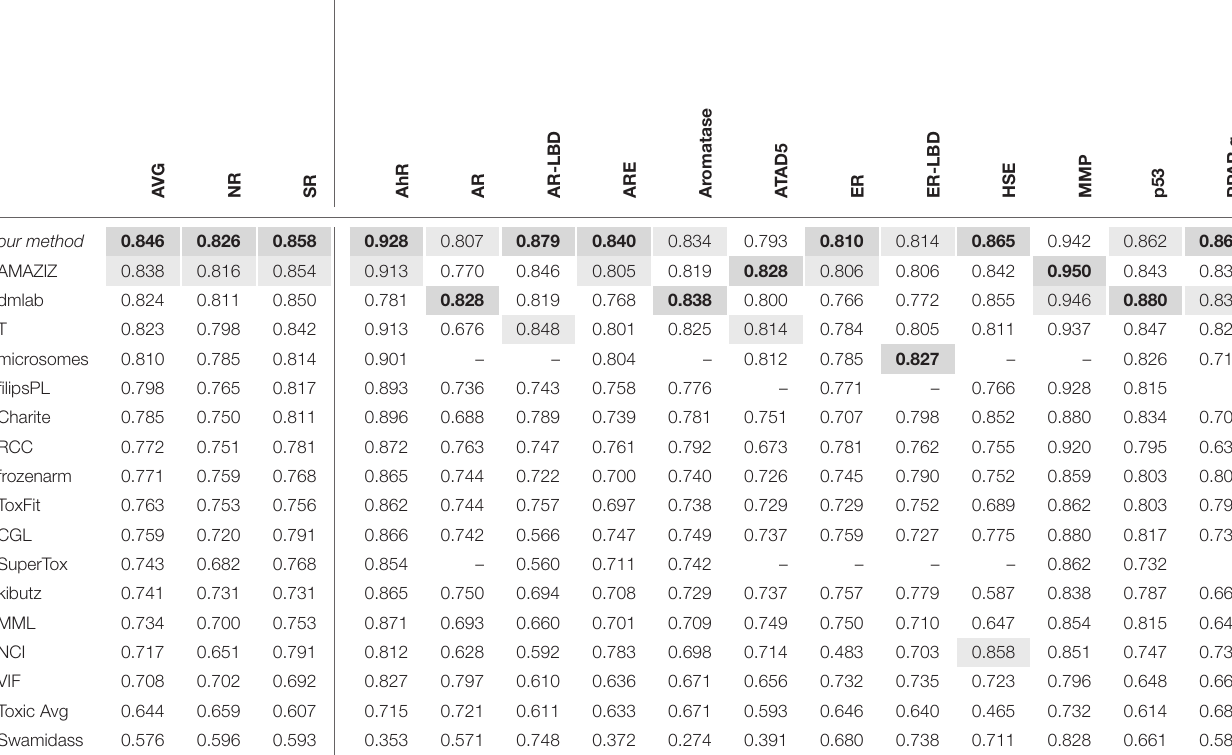
TABLE 5 | The leading teams’ AUC Results on the final test set in the Tox21